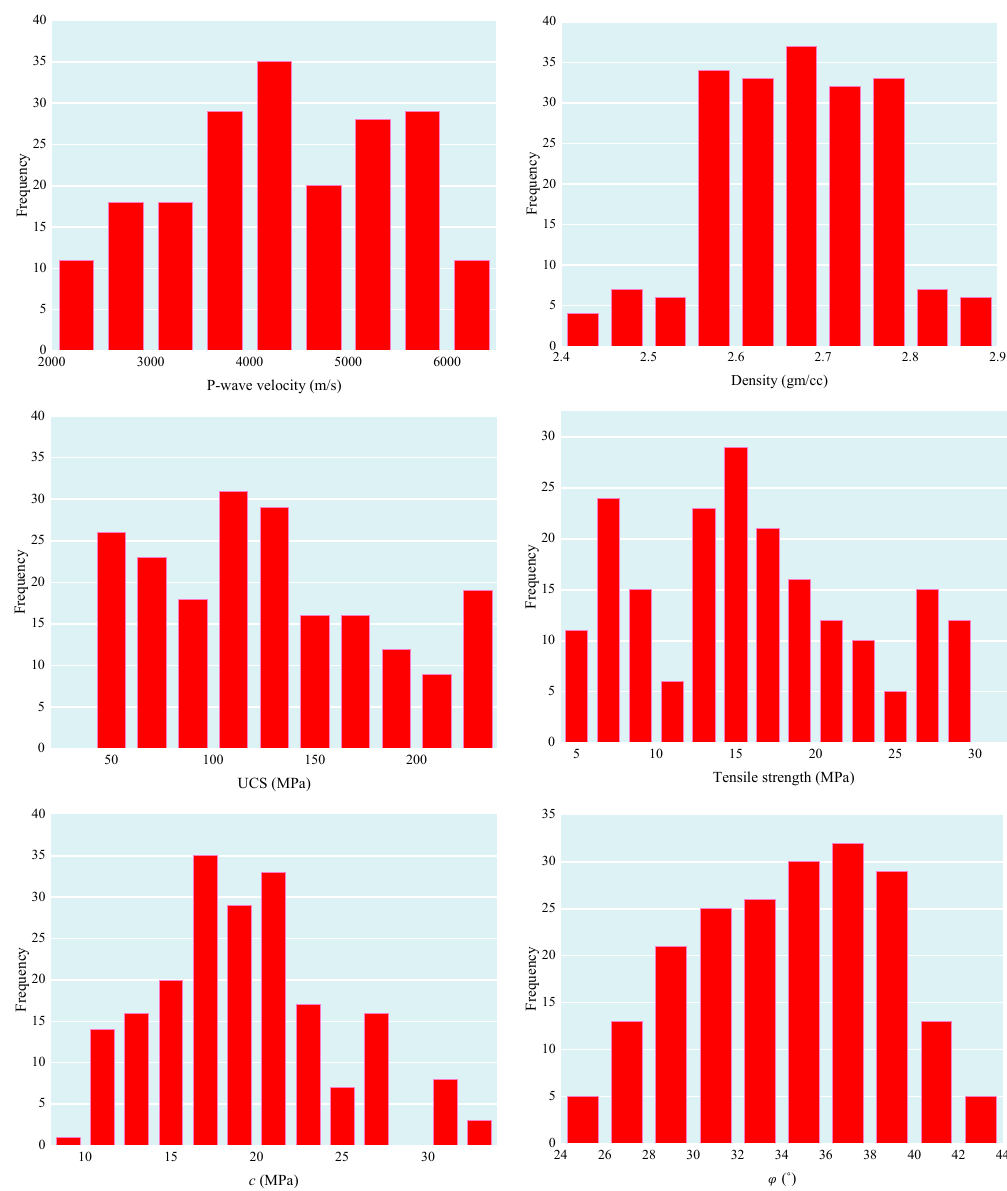
Figure 2. The statistical description of the inputs and output parameters of the actual dataset. Table 1. Lithology-based minimum and maximum, mean, and standard deviation (STD) values of the dataset in this study.